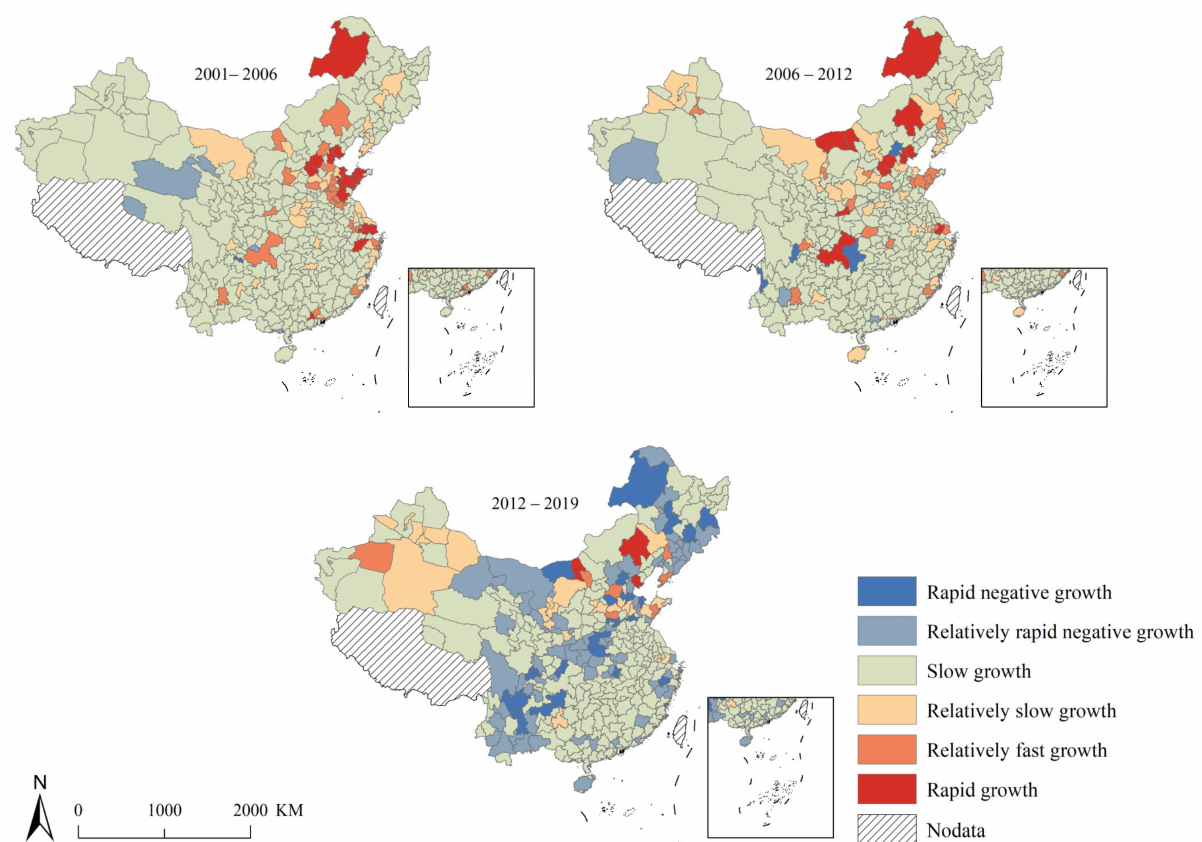
Figure 8. The slope of carbon emission change at the city